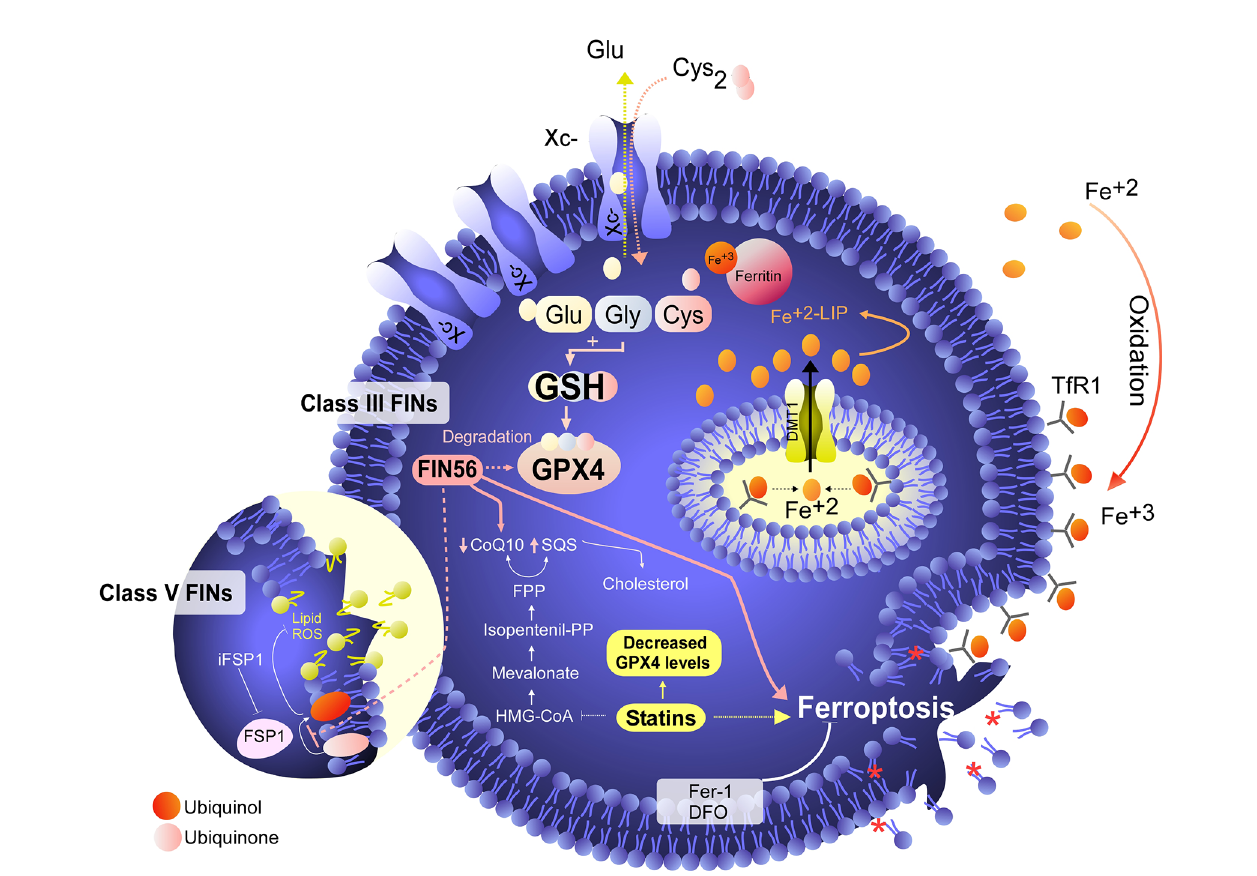
FIGURE 4 | Degradation of GPX4/CoQ10 or inhibition of FSP1 induces ferroptosis in cancer cells. Class III FINs are molecules that act independently of system x − c activity, the GSH level and direct inhibition of GPX4. These molecules, including FIN56, induce degradation of GPX4, which leads to ferroptosis induction. In addition to degrading GPX4, FIN56 also induces degradation of coenzyme Q10 (ubiquinone) by altering the mevalonate pathway. The importance of coenzyme Q10 degradation in the execution of ferroptosis is assumed because the function of a protein called FSP1 (a class V FIN) was recently described (33, 34). In this scenario, FSP1 converts extramitochondrial ubiquinone (the oxidized form of coenzyme Q10) to extramitochondrial ubiquinol (the reduced form of coenzyme Q10), and ubiquinol acts as an endogenous RTA that inhibits ferroptosis independent of the presence of GPX4. In this context, by inducing coenzyme Q10 degradation, FIN56 can inhibit the effects of FSP1 to confer resistance to ferroptosis. On the other hand, the inhibitor of FSP1 (iFSP1) controls ferroptosis without degrading